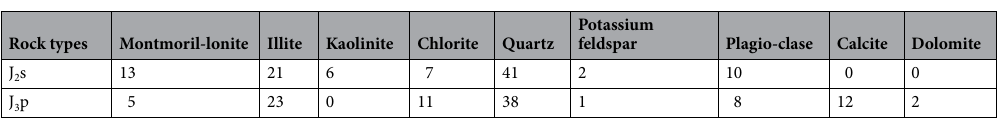
Table 1. Mineral contents (%) of the two purple mudstones.